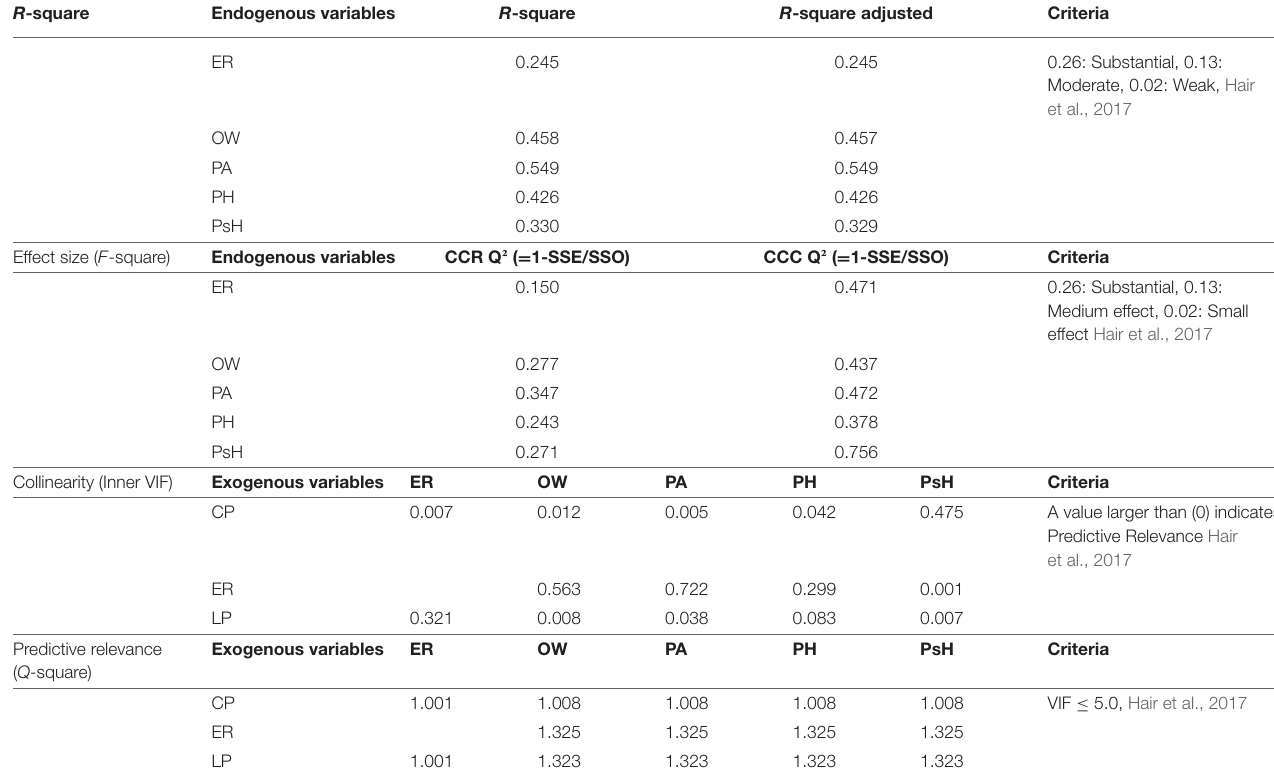
TABLE 5 | Assessment of structural equation model ( N = 2,200).